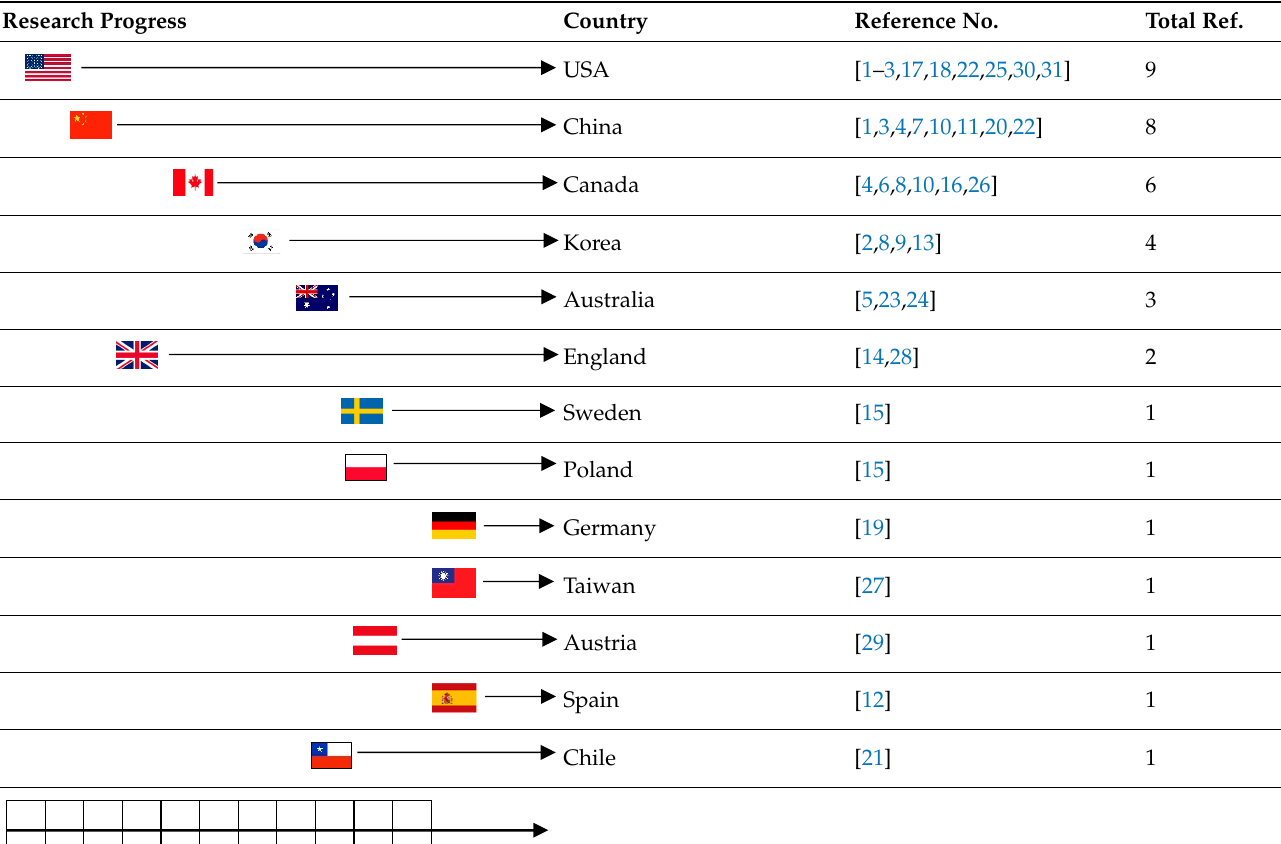
Table 2. Research progress in the field of corrosion in rock bolts. Research Progress